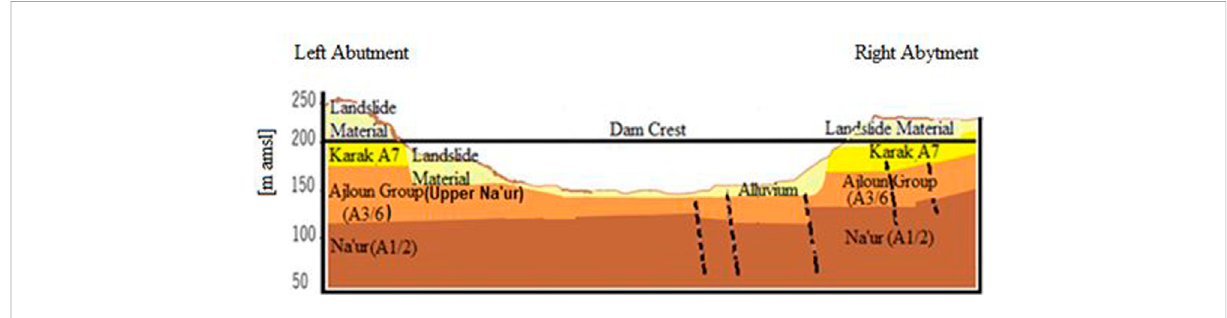
FIGURE 2 Dam site geological formations (faults are plotted in dotted